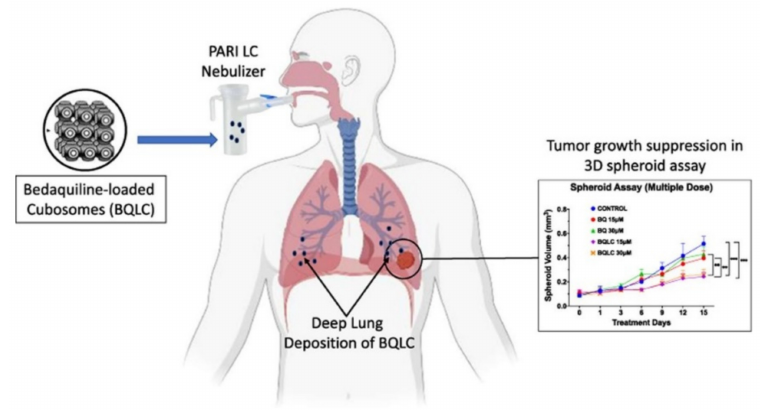
Figure 9. Conceptual representation of the work by Patil et al., 2021. Bedaquiline-loaded cubosomes were designed for inhalatory administration in the context of cancer therapy. Reproduced with permission from reference [97]. Copyright 2022